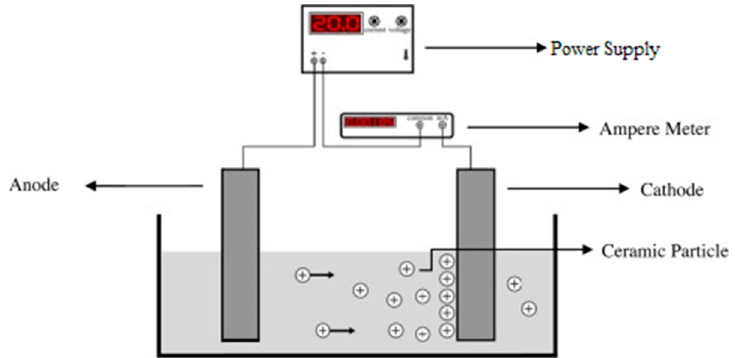
Figure 7. Schematic view of simple electrophoretic deposition process [108].